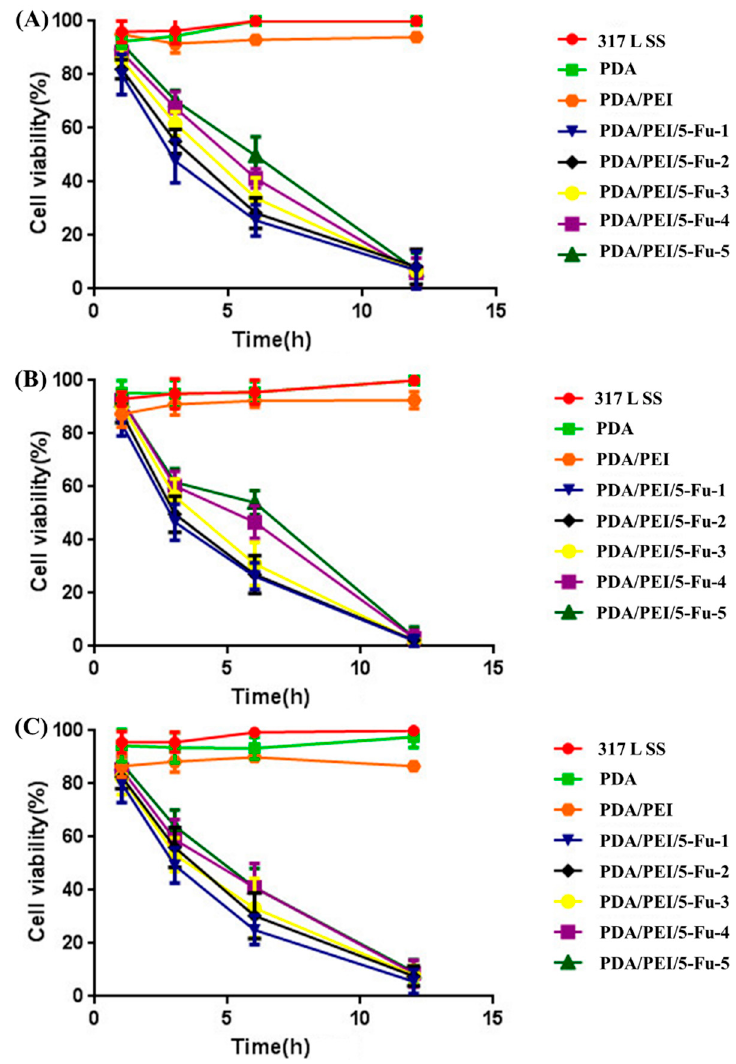
Figure 7. Statistical analysis of ( A ) Eca109, ( B ) Het-1A and ( C ) L929 cells apoptosis and necrosis (by counting cell viability) influenced by the 5-Fu released from the PDA/PEI/5-Fu layers and reference surfaces (mean ± SD, n = 3).